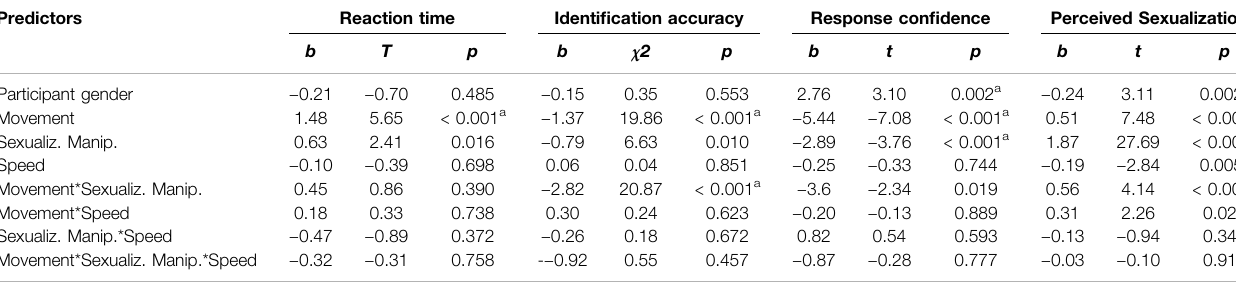
TABLE 4 | Mixed linear models for predicting main outcome by conditions.